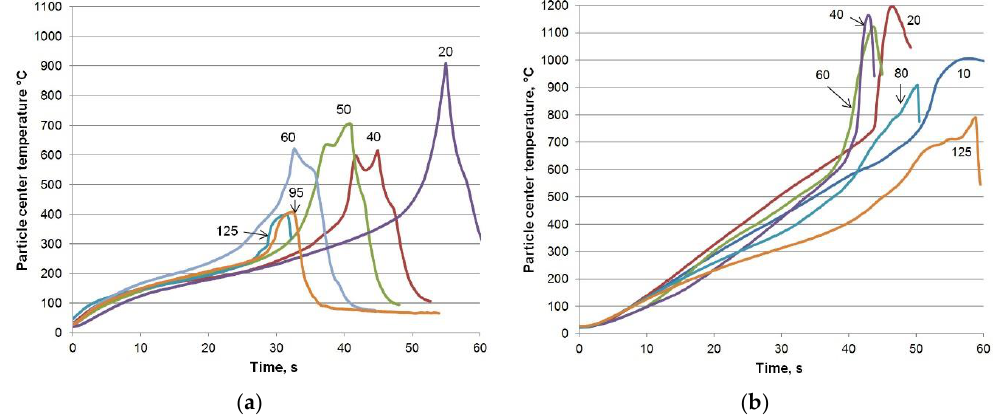
Figure 14. Change of particle center temperature in time at different tuyere air velocity. Combustion in the free space of the furnace ( a ) and the inert channel ( b ), T furnace—800 °C, the captions indicate air velocities.